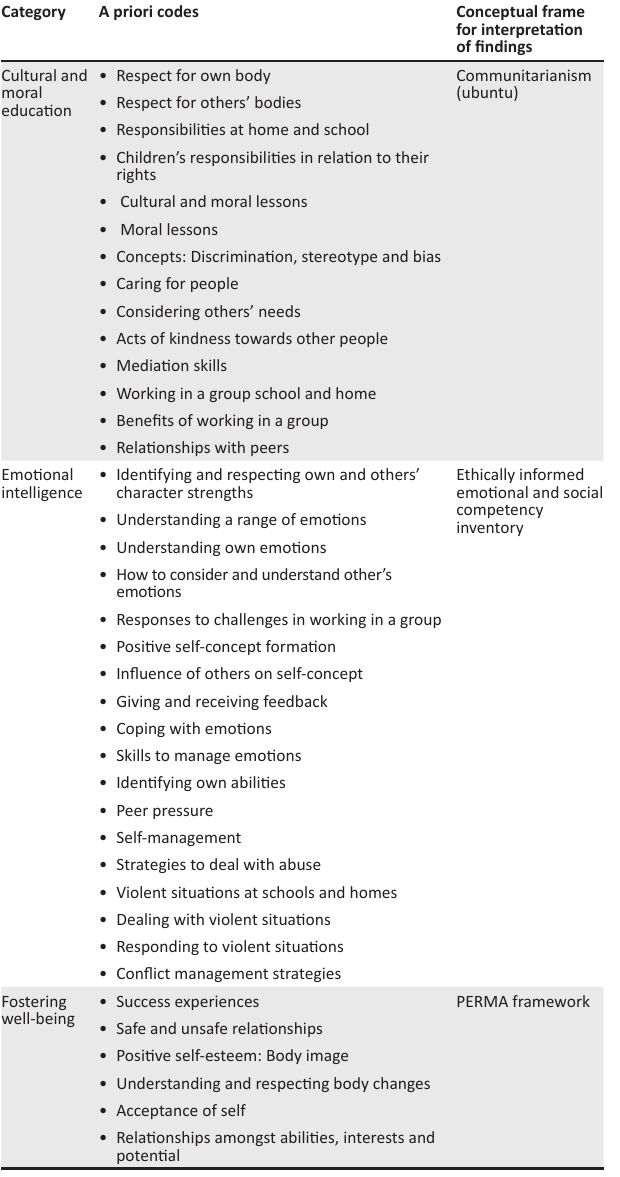
TABLE 1: A list of categories with their associated a priori codes and accompanying conceptual frames for interpretation. Category A priori